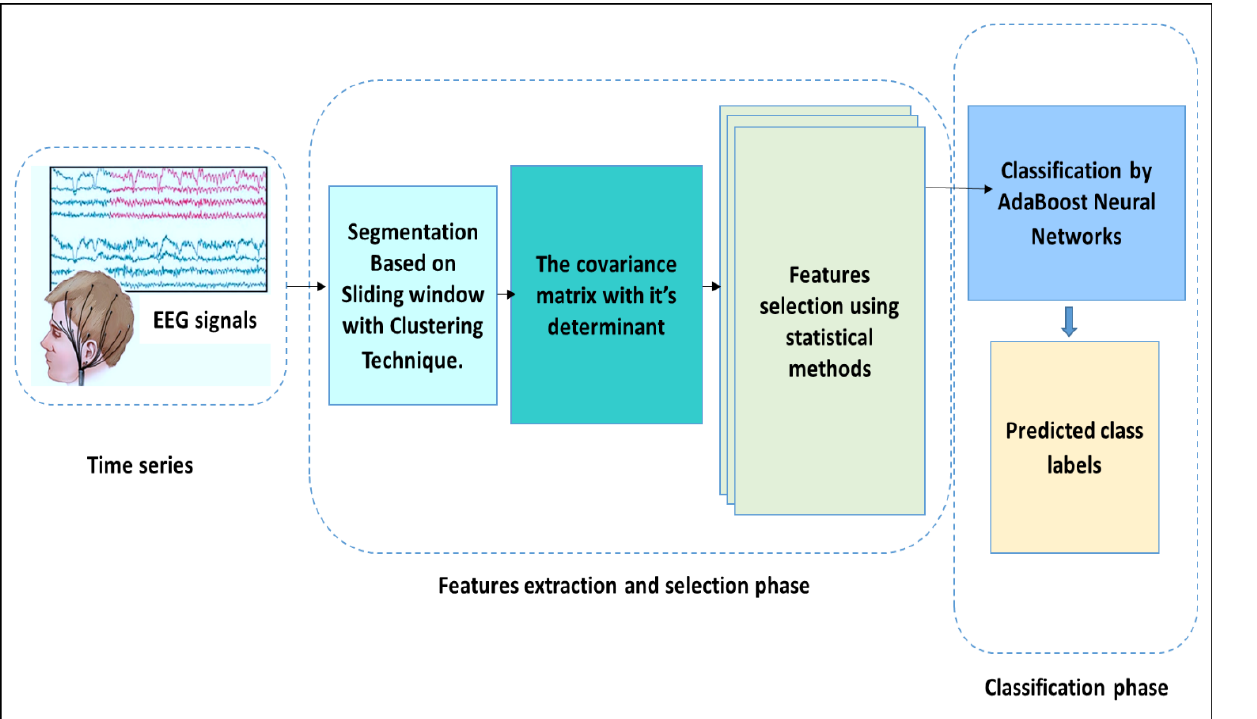
Figure 1. The proposed methodology for EEG signal analysis.